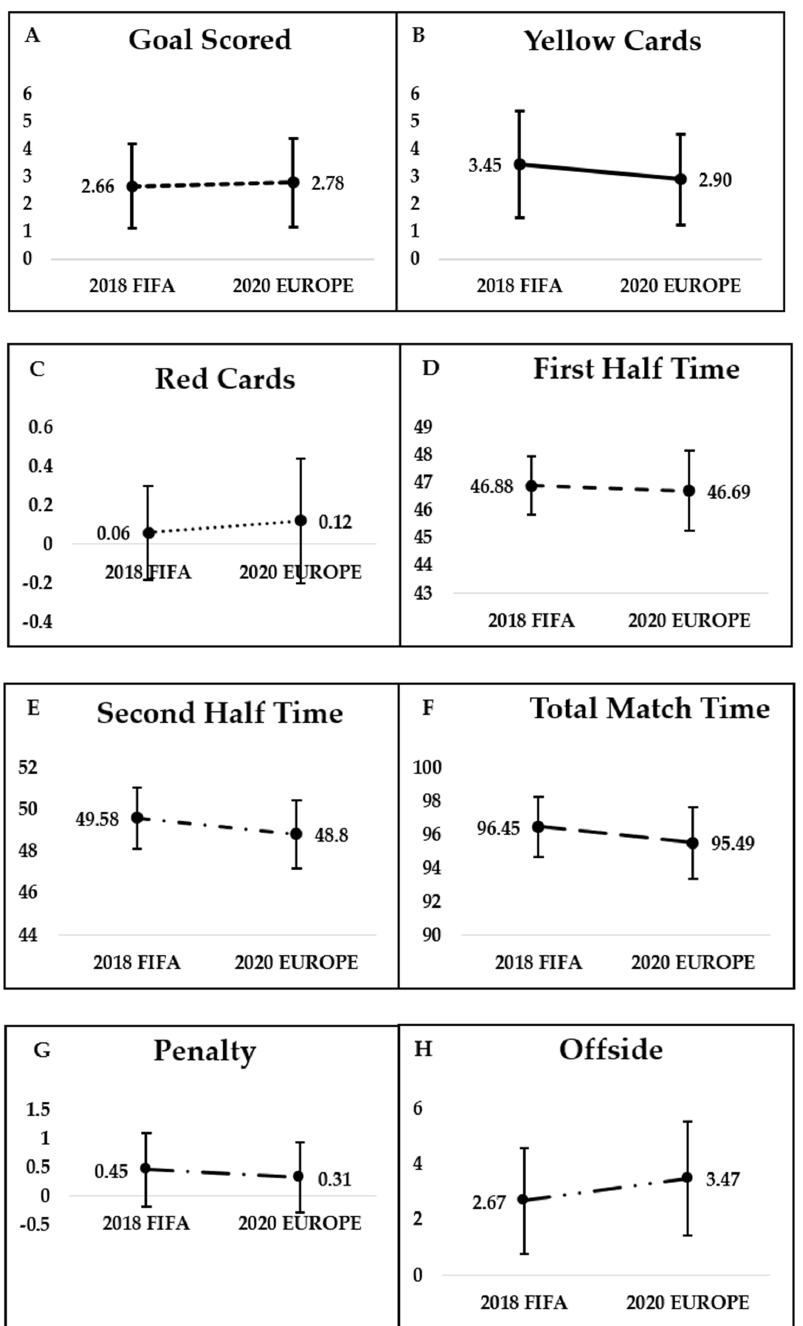
Figure 1. Differences of variables with the VAR application in the 2018 FIFA World Cup and the 2020 European Football Championship.